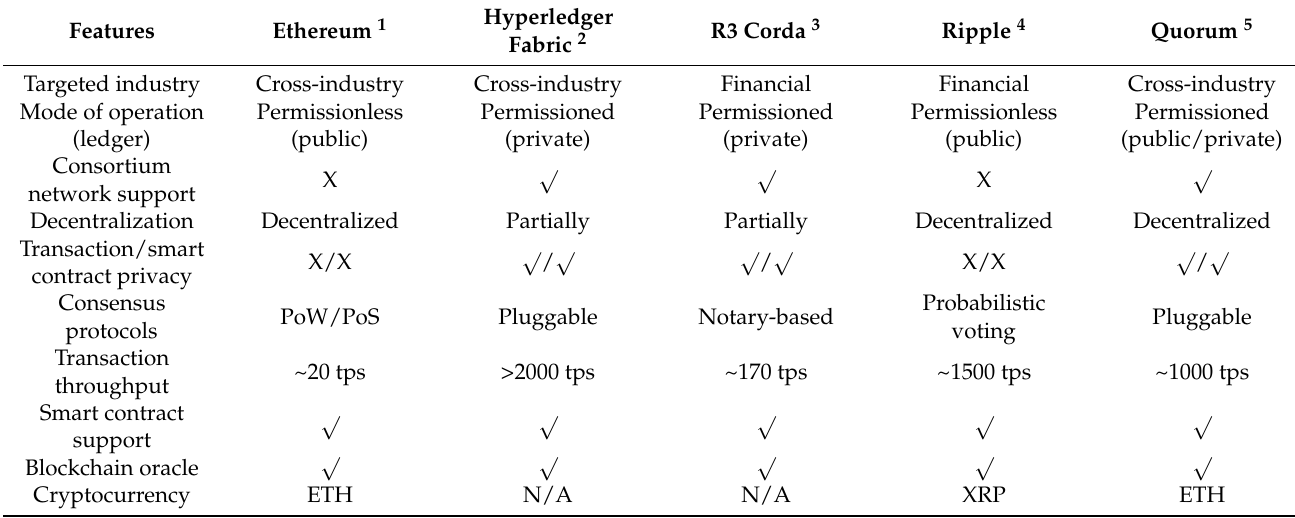
Table 1. Comparison of the five popular blockchain platforms: Ethereum, Hyperledger, R3 Corda, Ripple, and